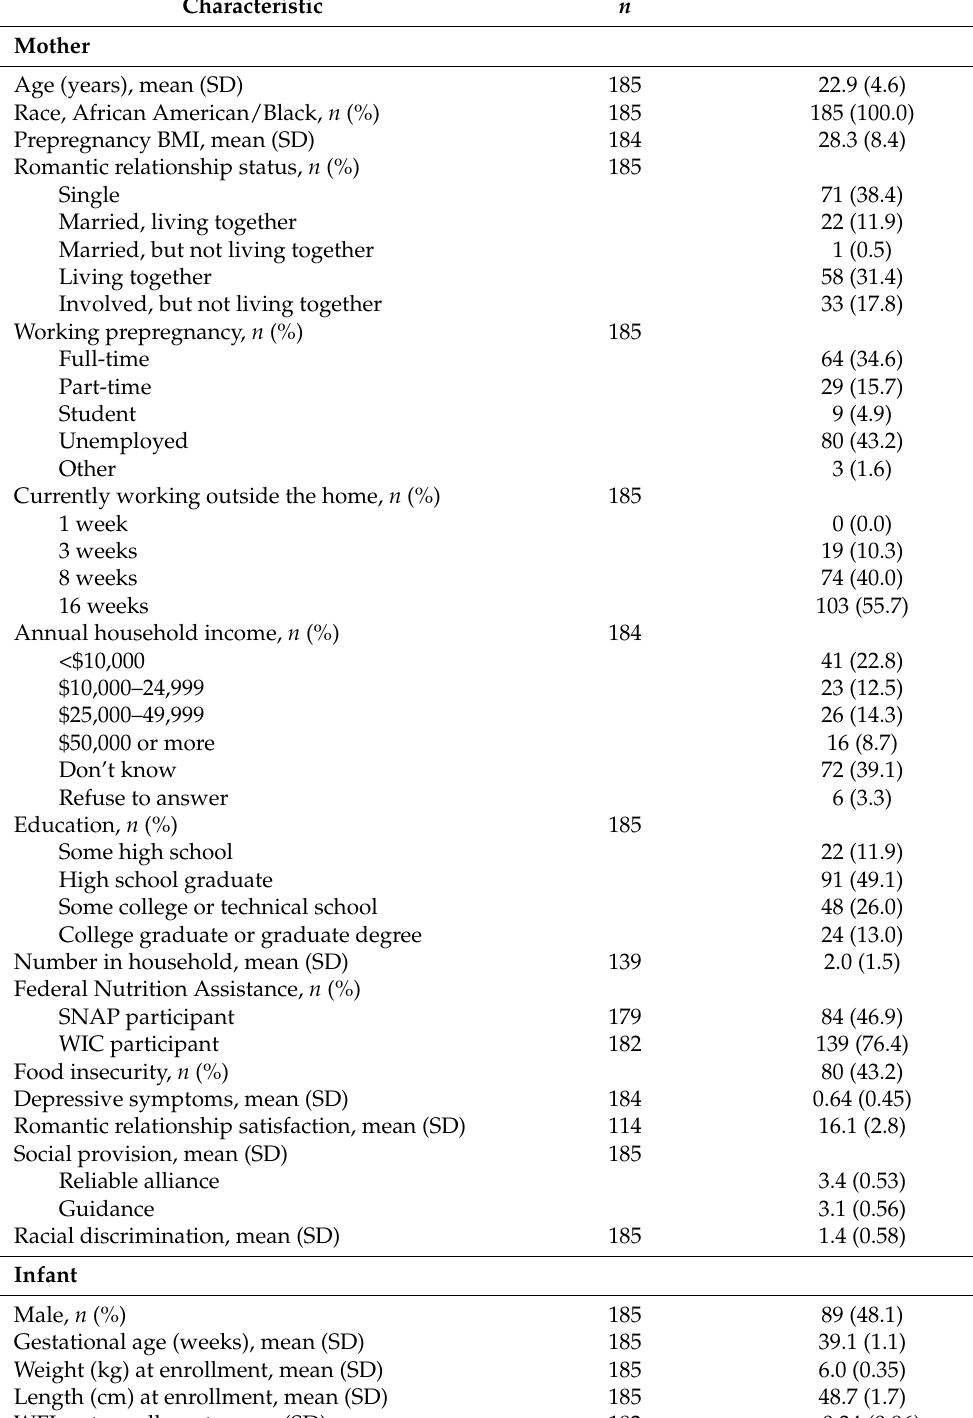
Table 1. Characteristics of mother–infant dyads ( n =